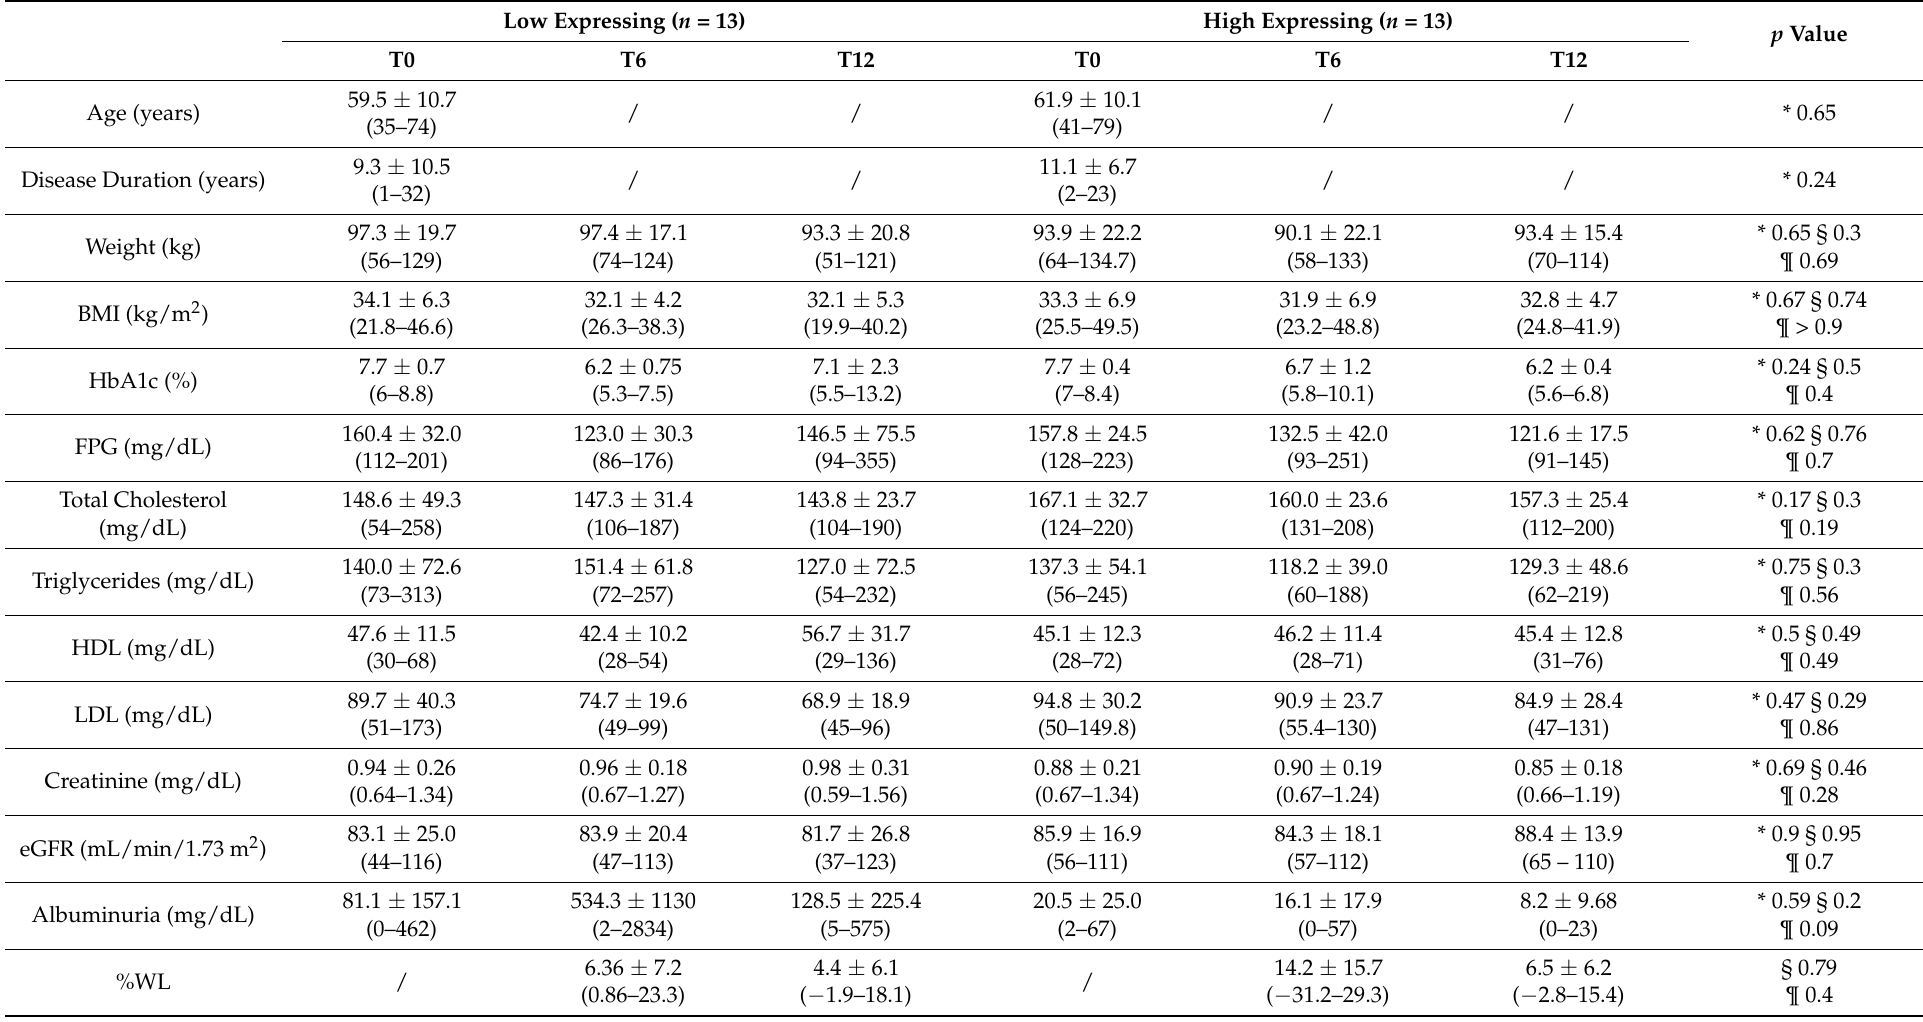
Table 3. Anthropometric measures and metabolic data in low expressing group and high expressing